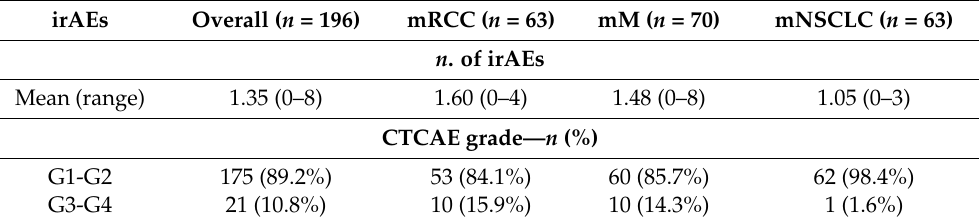
Table 2. Number and CTCAE grade of